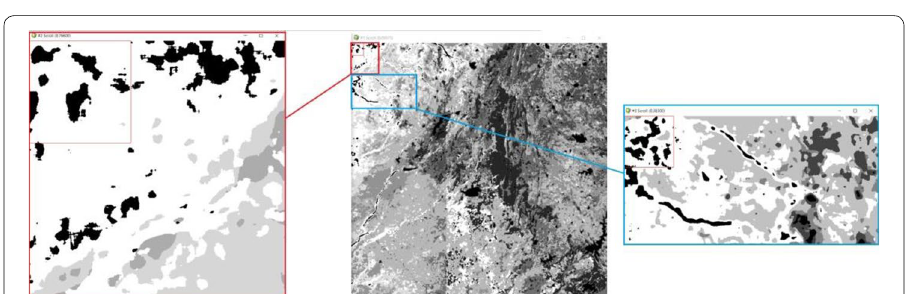
Fig. 12 Clipping two parts of different sizes from an